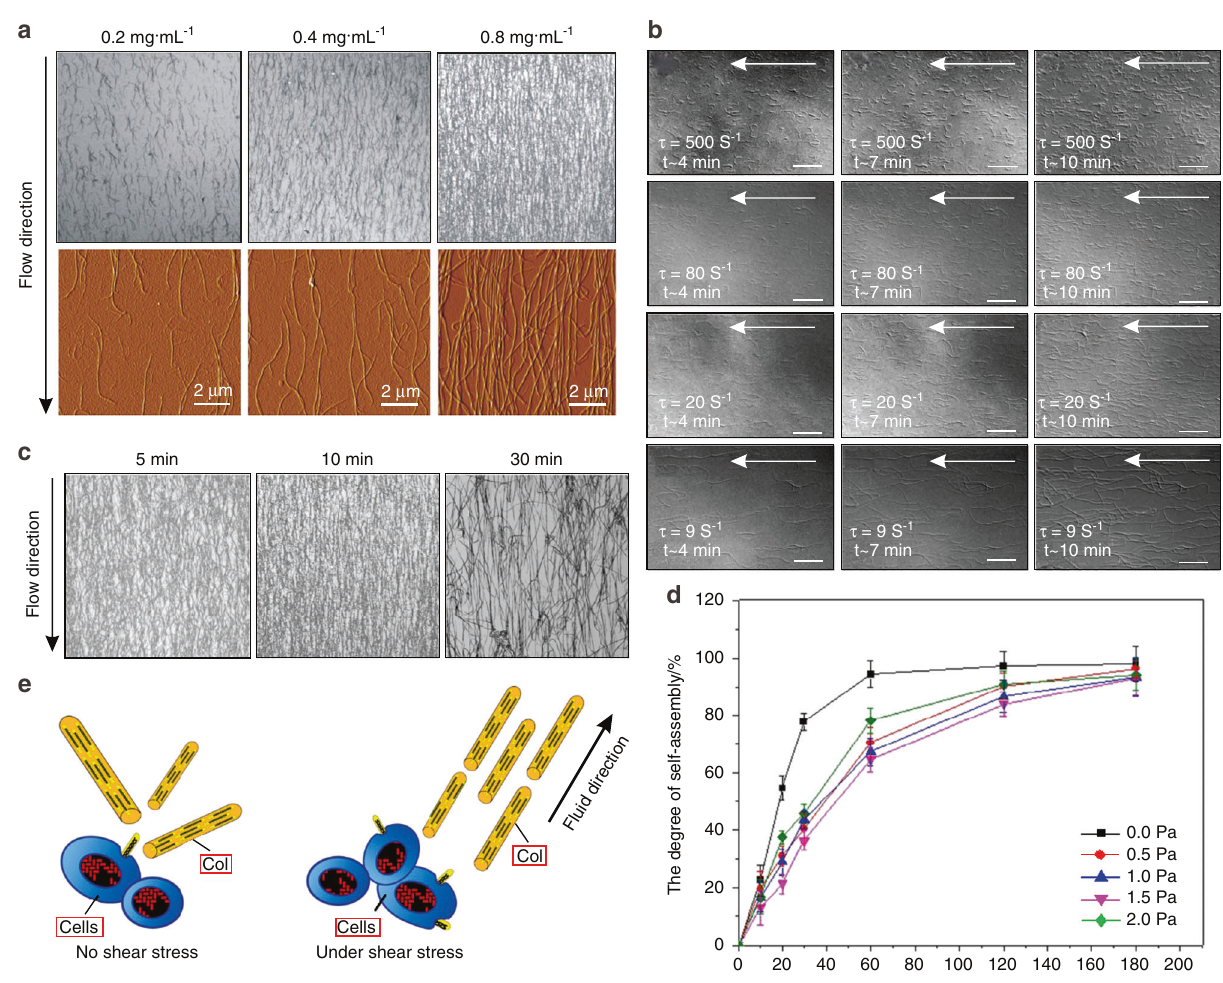
Fig. 8 In an in vitro system without cells, the orientation of Col fi bers along the fl ow directions. ( a ) 90 and FSS can promote the orientation of Col fi brils at a certain size ( b ) 91 and a certain action time ( c ) 90 . The fi bril density increased with increasing concentrations of Col solution. Confocal re fl ection microscopy ( fi rst row) and atomic force microscopy (second row) images of Col fi ber matrices prepared at concentrations of 0.2 mg·mL − 1 , 0.4 mg·mL − 1 , and 0.8 mg·mL − 1 with a fl ow rate of 11 mL·min − 1 and conditioning time of 5 min ( a ) 90 . The orientation is optimal at a conditioning time of 10 min ( c ) 90 . Col fi bril self-assembly at 500, 80, 20, and 9 S − 1 shear rates, and the arrangement of Col fi brils is optimal at a shear rate of 20 – 80 S − 1 ( b ) 91 . d Degree of Col self-assembly over 0, 0.5, 1.0, 1.5, and 2.0 Pa FSS for 10, 20, 30, 60, 120, and 180 min, respectively 11 . e Effects of FSS on Col. FSS can promote the orientation of Col fi bers with an increasing shear rate within a certain range. In addition to the Col fi ber arrangement, FSS can also induce Col fi bril expression, making the Col fi ber diameter distribution more uniform. Figures adapted with permission from refs.